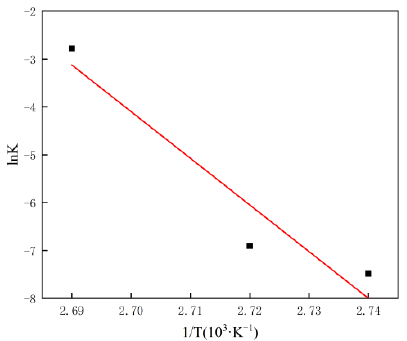
Figure 5. Arrhenius plots of the growth process for the α -HH samples synthesized by the hydro- Figure 4 . The plot of ln ( − ln (1 −α )) vs. ln (t) for α -HH sample synthesized via hydrothermal meth- thermal method. od.